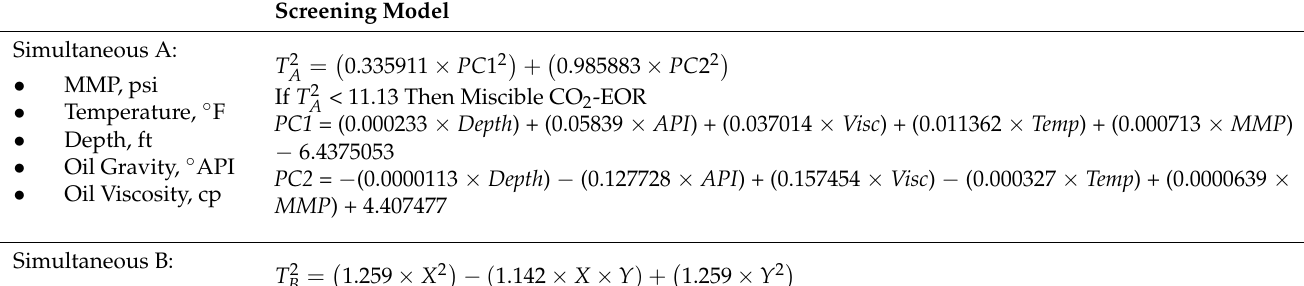
Figure 8. ( a ) Scree plot and ( b ) eigenvectors of PCA for miscible CO 2 -EOR simultaneous screening model A.